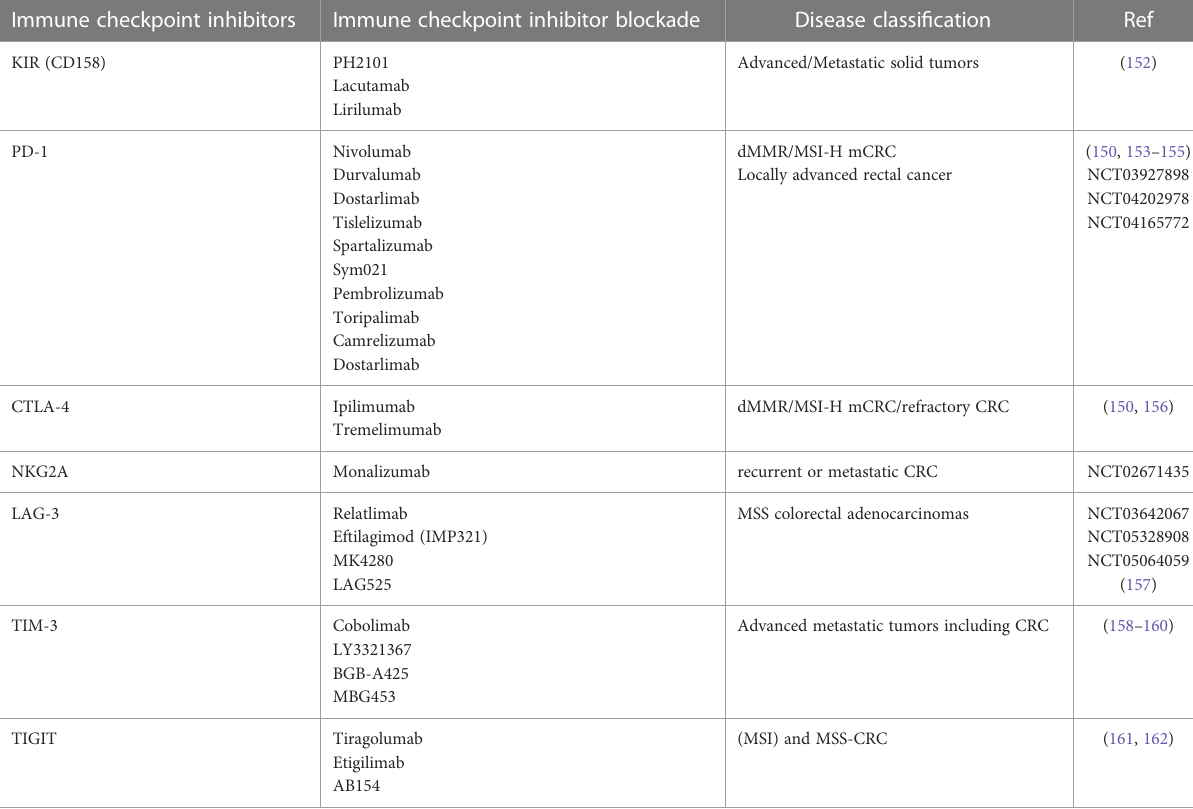
TABLE 2 Immune checkpoint inhibitors present on NK cells and their blockade under clinical and preclinical investigations in CRC. Immune checkpoint